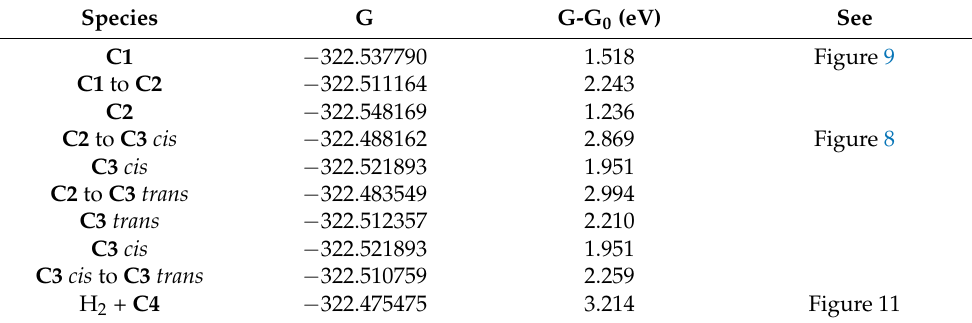
C 2021 , 7 , x FOR PEER REVIEW